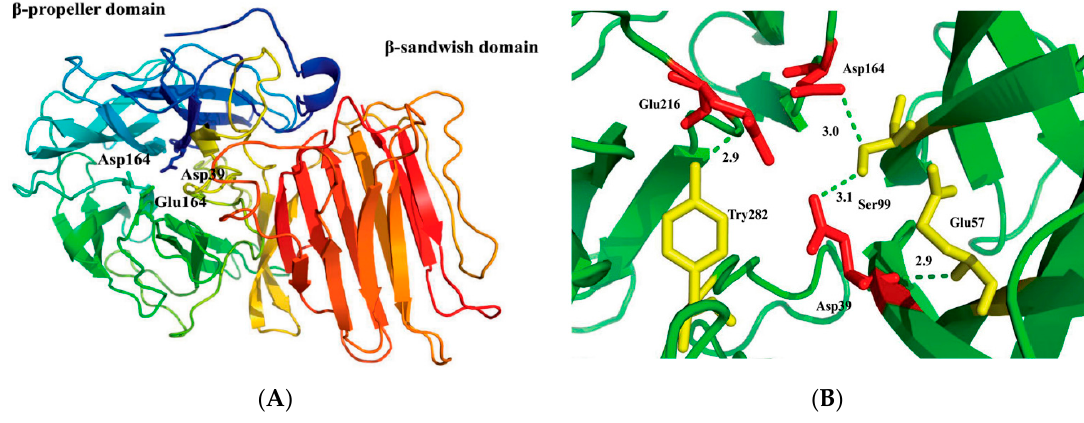
Figure 1. The predicted 3D structure and active sites of the r ‐ Ao FT. ( A ) The overall structure of r ‐ Ao FT consists of a N ‐ terminal fivefold β‐ propeller domain and a β‐ propeller domain. The active sites Asp39, Asp164, and Glu 216 are shown in different colors; ( B ) The hydrogen bonds with numbering of residues interacting with active sites of r ‐ Ao FT. The corresponding distances are given in Å. The model was generated with the threading program Phyre using the fructofuranosidase from Schwanniomyces occidentalis (PDB: 3u75.1A) as the template.